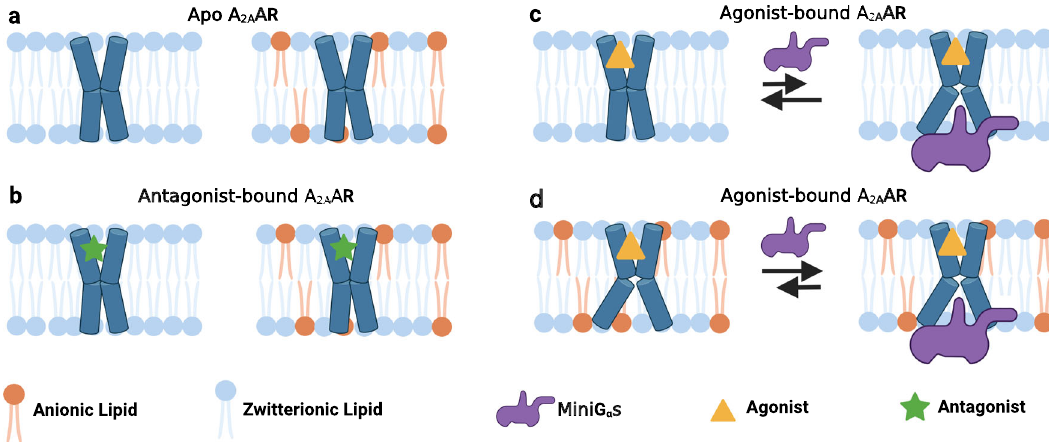
Fig.6|VisualizationoftheroleofanioniclipidsincomplexformationofA 2A AR with G α S . a , b Schematic side views of a apo and b antagonist-bound A 2A AR in phospholipidmembraneswithoutandwithanioniclipids,coloredblueandorange, respectively. c , d Schematic view of agonist-bound A 2A AR and mini-G α S in mem- branescontaining c onlyzwitterionicphospholipidsand d zwitterionicandanionic